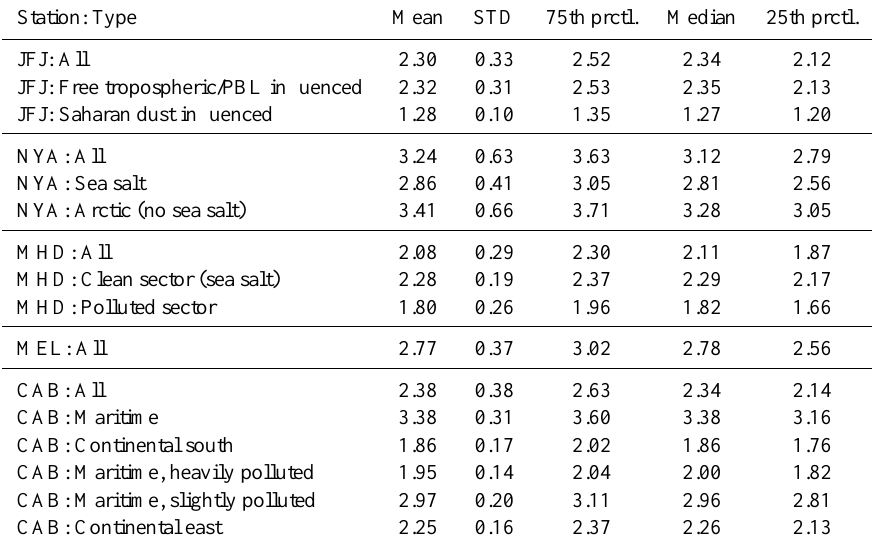
Table 2. Mean, standard deviation (STD), and percentile values of f (RH = 85%, 550nm) for the Jungfraujoch (JFJ), Ny-Ålesund (NYA), Mace Head (MHD), Melpitz (MEL), and Cabauw (CAB). Average values are also given for different air mass types, if a differentiation of specific air masses was possible during the individual measurement